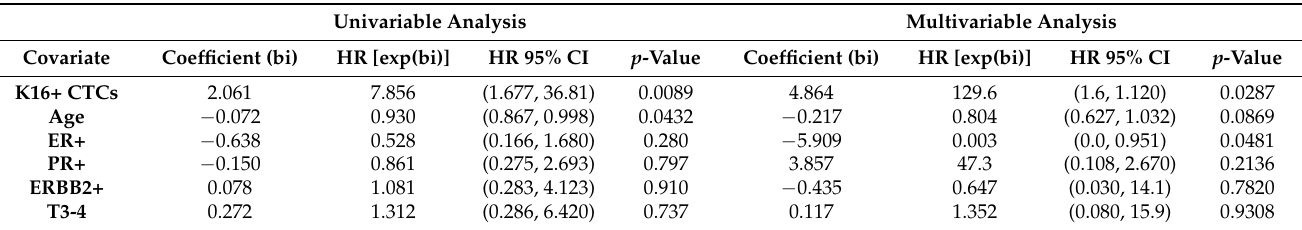
Table 2. Cox proportional hazard ratios. Estimated coefficients of relapse-free survival on breast cancer subjects. Calculated are the corresponding hazard ratio (HR), 95% confidence interval (CI) of the hazard ratio, and p -value in uni- and multivari- able Cox proportional hazard analysis for the presence of K16-positive CTCs, estrogen receptor (ER) status, progesterone receptor (PR) status, ERBB2 status, and T-stage (reference